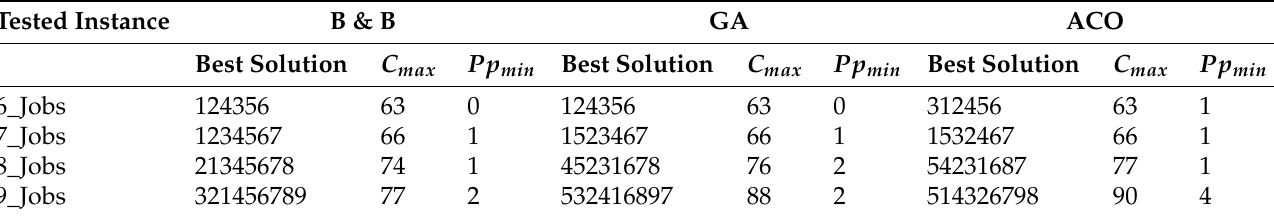
Figure 13. Comparison of the perishable products. Table 2. Experimental results of the B&B, GA, and ACO